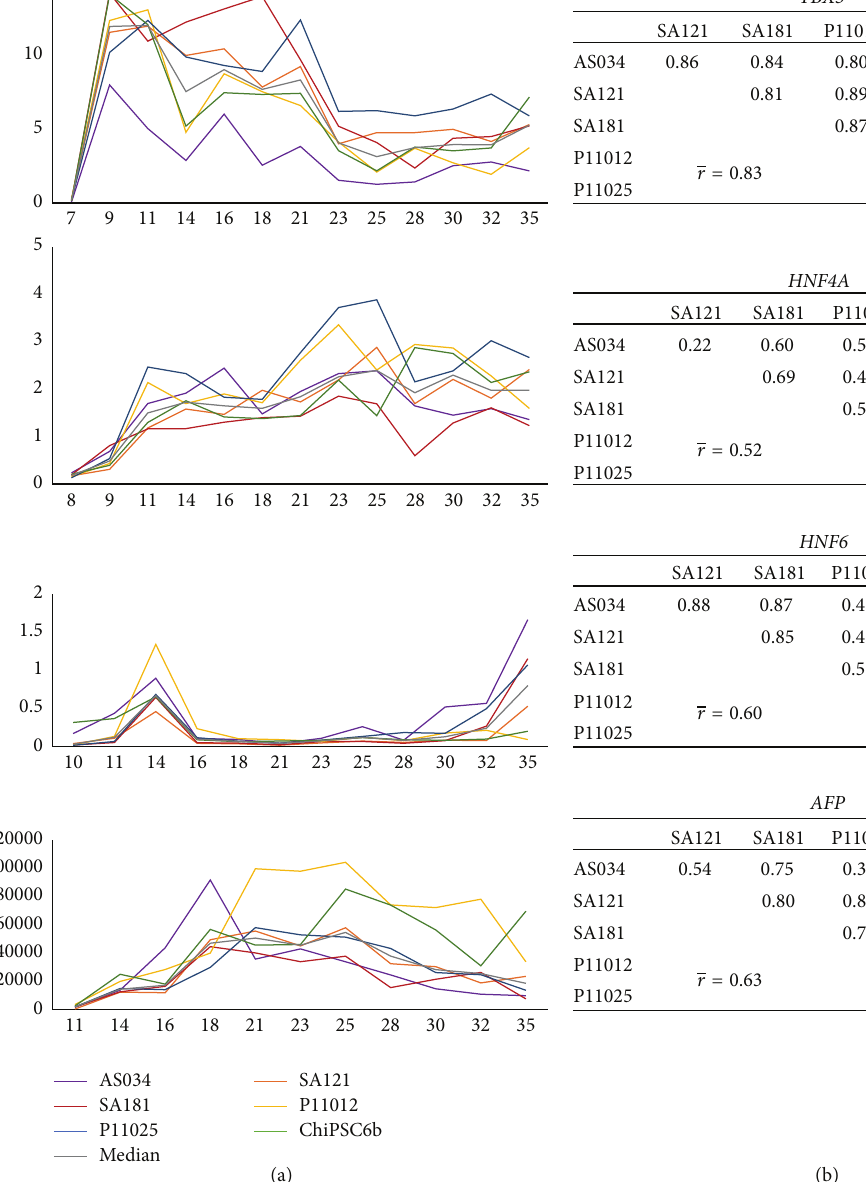
Figure 6: Gene expression profiles of early hepatic markers ( TBX3 , HNF4A , HNF6 , and AFP ) in the interval from day 7 to day 35. (a) The 𝑥 -axis indicates the days during differentiation and the 𝑦 -axis indicates RQ, where the calibrator’s RQ = 1. The colored lines show the results from each individual hPSC line and the grey line indicates the calculated median value of the RNA level. Correlation tables are shown in (b). The graphs show synchronicity of onset as well as up- and downregulation among all cell lines for the genes TBX3 , HNF4A , HNF6 , and AFP. The average correlation between pairs of cell lines ranges from moderate (0.52 for HNF4A ) to very strong (0.83 for TBX3